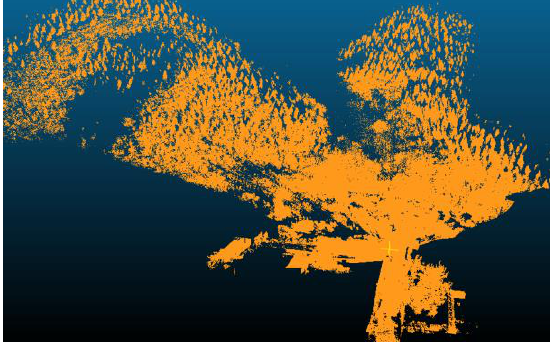
When laser scanning ended, camera would start taking color images by revolving around the z axis of LiDAR coordinate system in horizontal direction at 0-360 degree. The rotation angle between adjacent images is 30 degree ( 𝛼 = 30° ), and can get 12 images (see Figure 3). Therefore, rotation vector of adjacent images can be defined as V = [0 0 30°𝜋/180] , and can transform in the form of Rodrigues matrix R angle (see Section